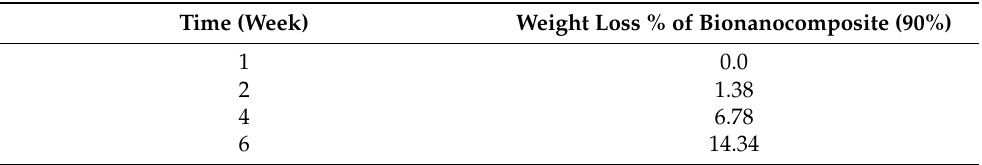
Figure 9. Thermogravimetric analysis of: ( a ) nutmeg oil/PU/ZnONPs bionanocomposite and nutmeg oil/PU and ( b ) nutmeg oil and PU. Table 2. Hydrolytic degradation of nutmeg oil/PU/ZnONPs bionanocomposite film (90%) expressed as weight loss (%).